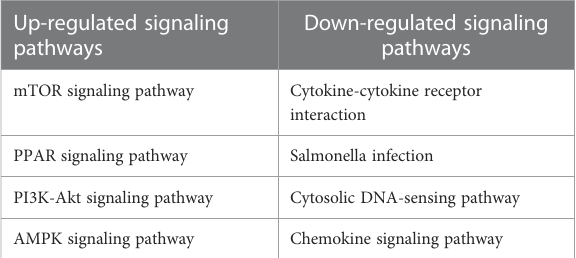
TABLE 6 List of KEGG pathways up-regulated and down-regulated between the experimental group at 24 h and the control group 0h.